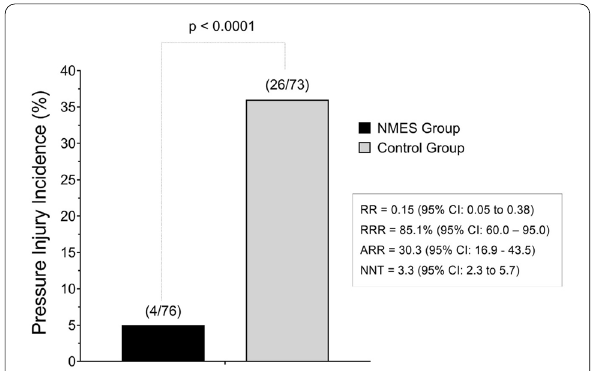
Fig. 5 Effect of NMES on pressure injury incidence. NMES: neuromuscular electrical stimulation; RR: relative risk; CI: